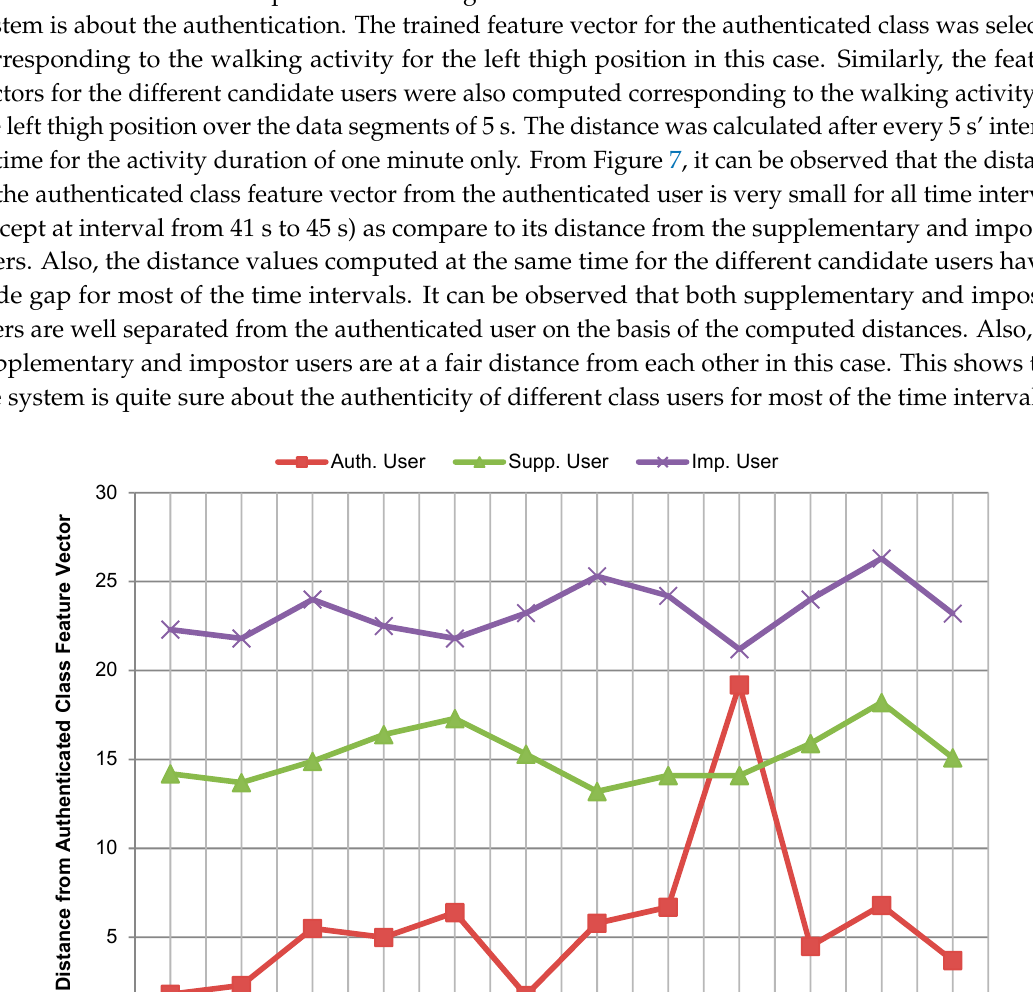
Figure 8. Output of the classification model at different time intervals while classifying a candidate user belonging to the authenticated class. The results of the user classification were computed iteratively for all possible permutations of the users across three folds, considering all the scenarios given in Table 7. Only the average results of all iterations are included in this section. To thoroughly analyze the results, different values were chosen for R (cid:3040)(cid:3036)(cid:3041) but no significant changes were observed in the results that were obtained